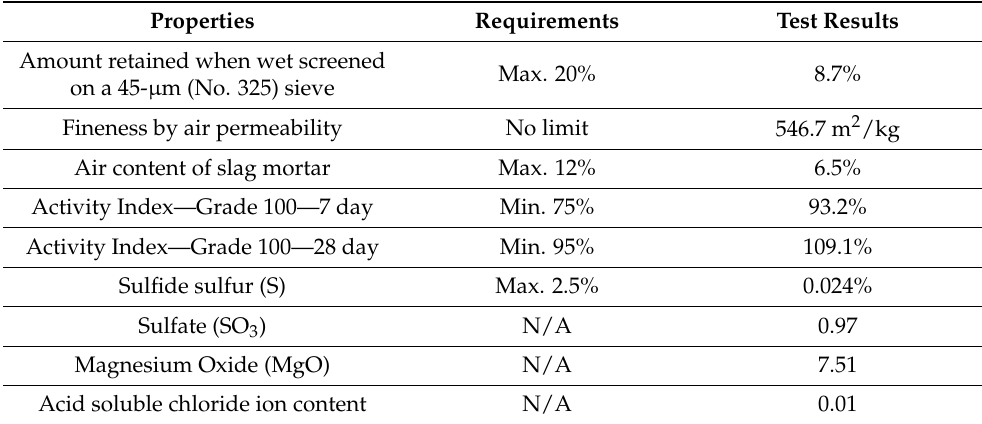
Table 3. Properties, requirements, and test results for GGBS according to ASTM C 989.